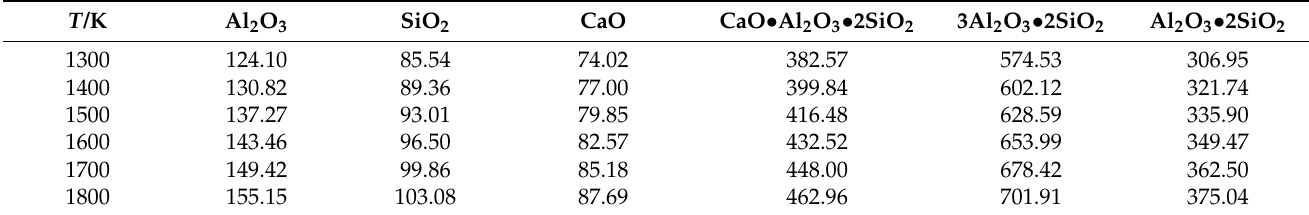
Table 2. Gibbs free energy ( Φ /J · mol − 1 · K − 1 ) of the substance at different temperatures.